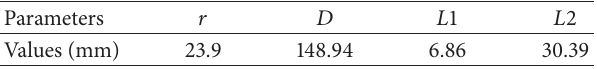
Table 4: Final dimensions of the 3D spherical antenna (Figure 4).